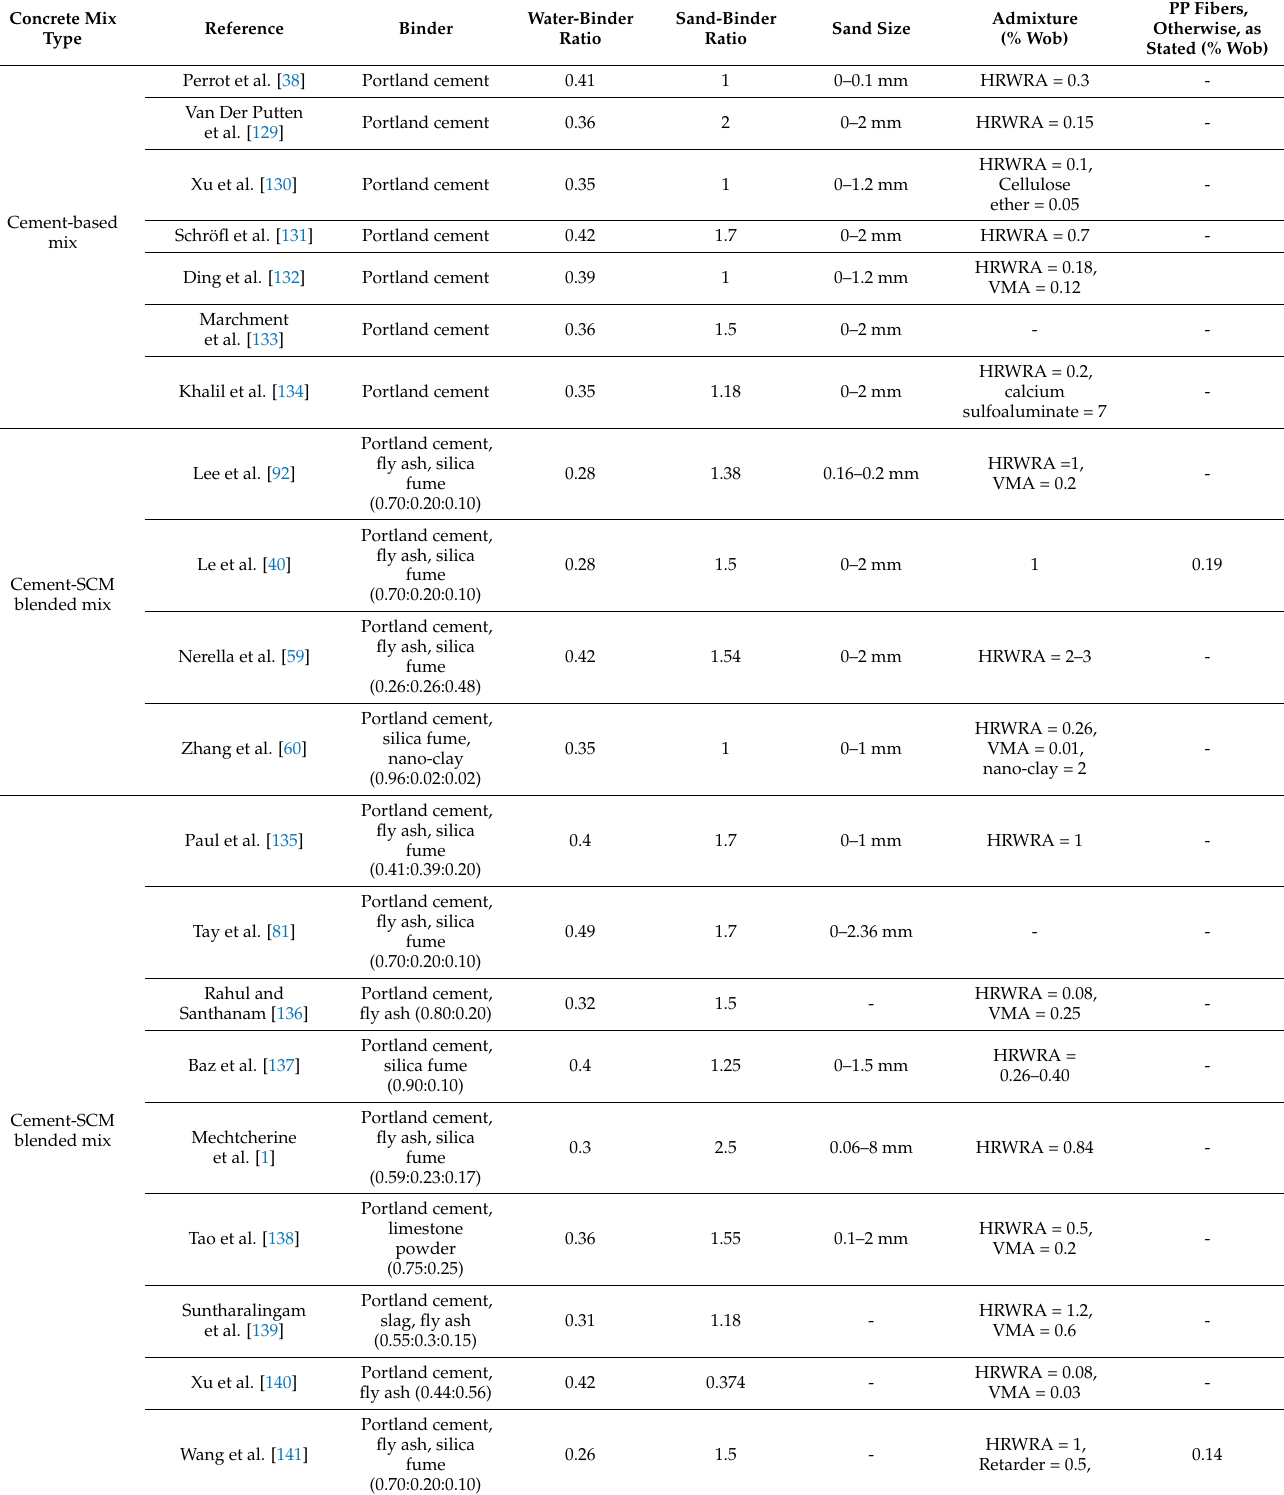
Table 3. Representative mix designs for 3D concrete